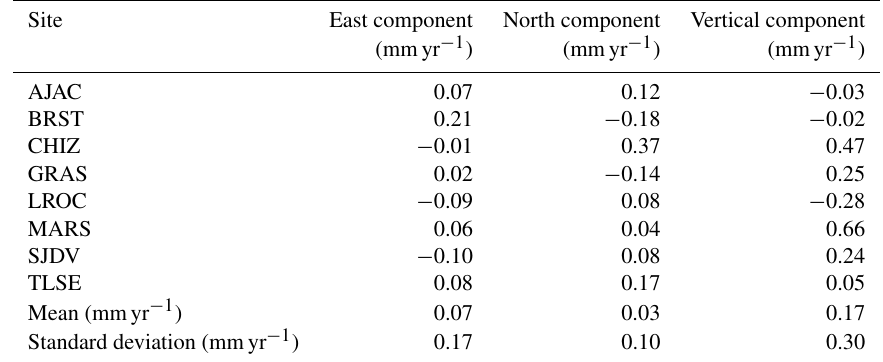
Table 2. Residuals between our velocity solution and the ITRF2008 velocities (Altamimi et al.,